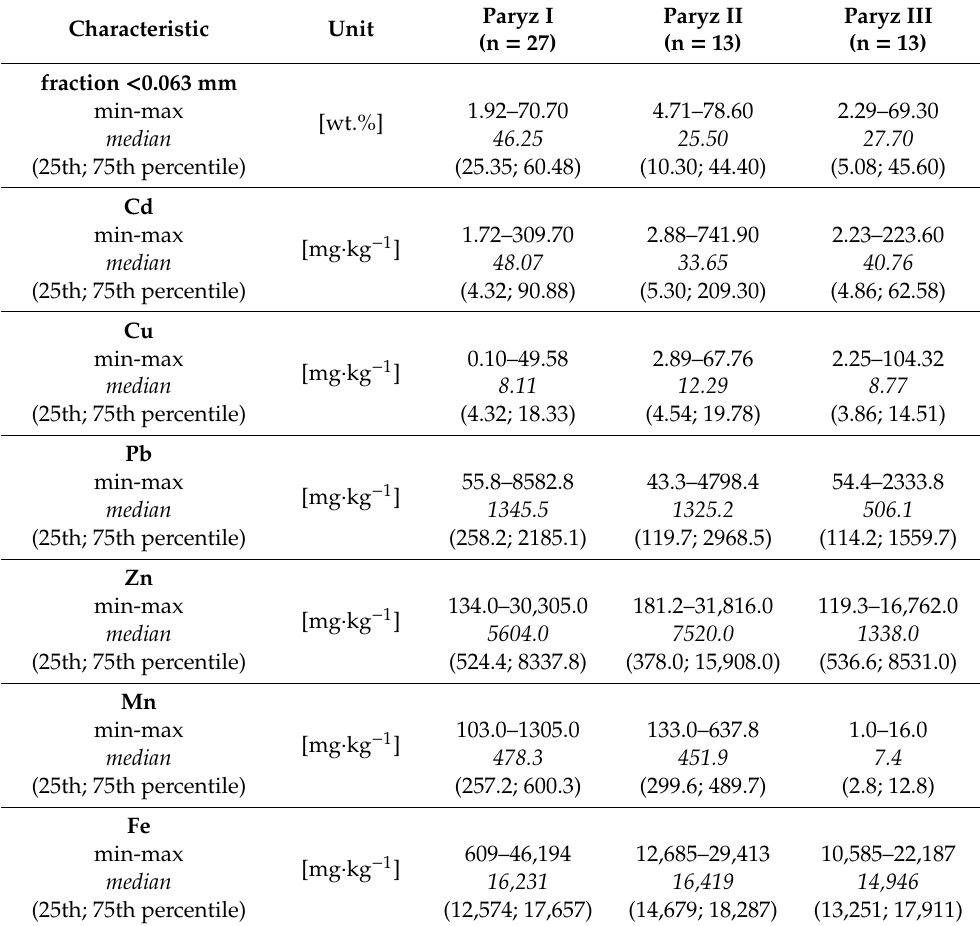
Table 4. Metals and silty-clay fraction concentration in the soil from profiles at the Paryz location.